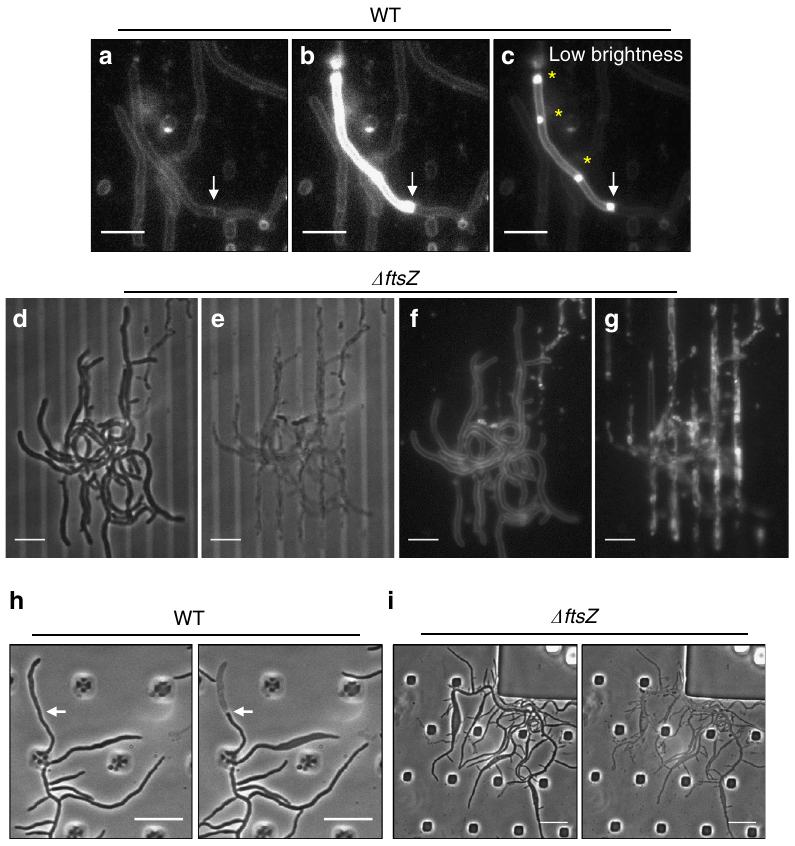
Fig. 2 Lack of compartmentalisation in the Δ ftsZ mutant. a – c Panels show FM4-64 membrane-stained wild-type cells grown in GYM media in a home- made micro fl uidic device. Panels b and c are equivalent, but with lower brightness in the latter. White arrow indicates the cell division site. Yellow asterisks show possible membrane accumulations. Scale bars = 5 µ m. d – g Panels show bright fi eld ( d , e ) and FM4-64 stained membrane ( f , g ) of the Δ ftsZ mutant grown in GYM in a home-made micro fl uidic device. Scale bars = 5 µ m. h , i growth of wild-type ( h ) and Δ ftsZ mutant ( i ) cells in the CellASIC ONIX micro fl uidic chamber in TSB media with constant lysozyme fl ow up to 1000 µ g ml − 1 . White arrows indicate the presumed presence of a division site. Scale bar = 5 µ